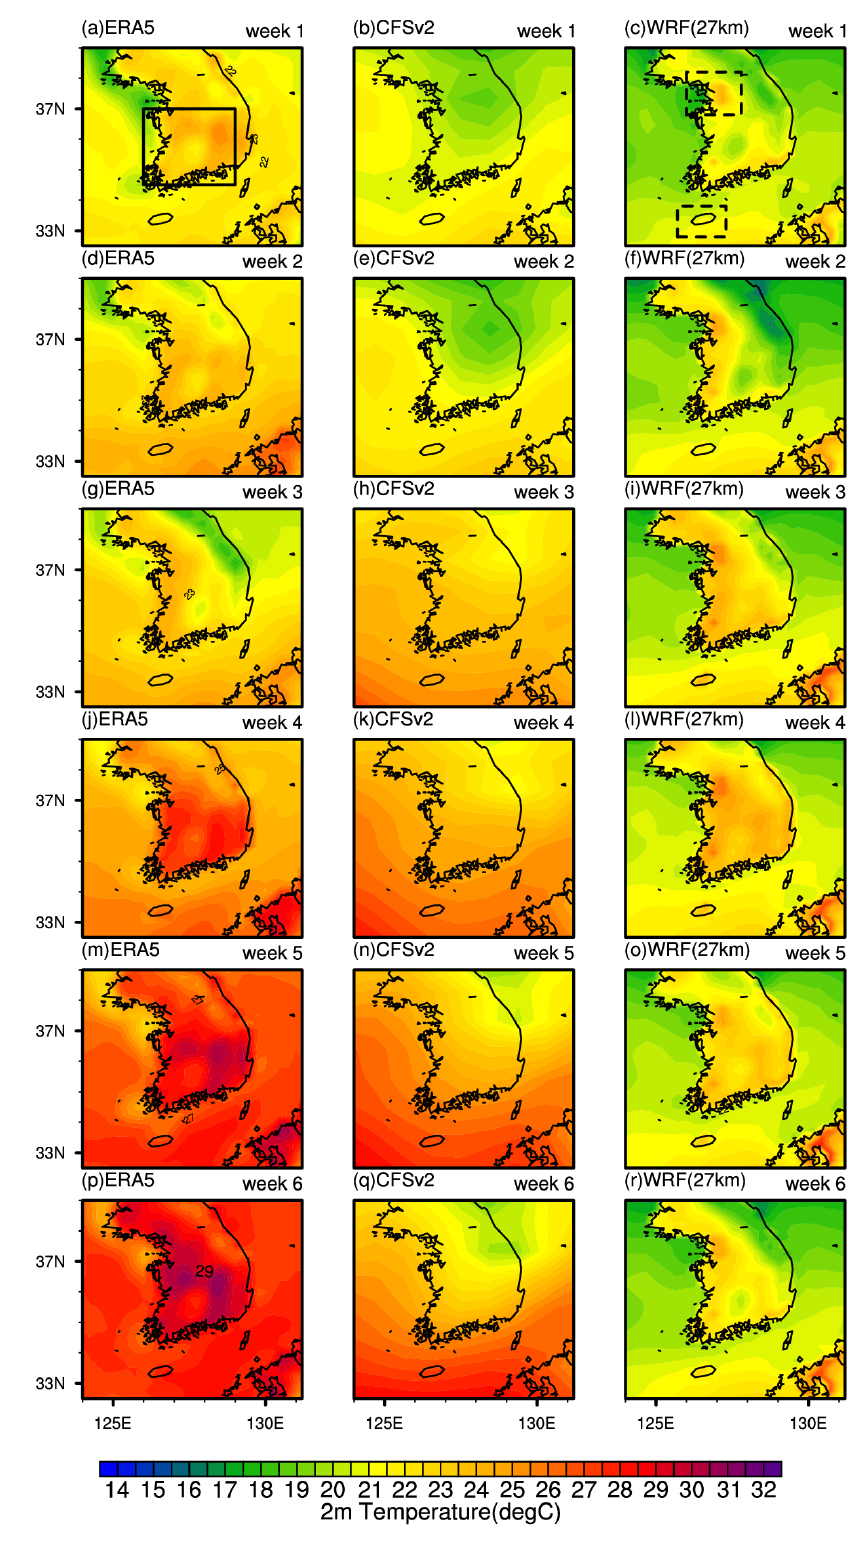
Figure 5. The weekly mean of the 2 m temperature in the ERA5 reanalysis and the CFSv2 and WRF forecasts initialized at 1800 UTC on 15 June. The solid box indicates the central and southern region in Korean Peninsula. The dotted box near 37 N represents Seoul, and the other box represents Jeju Island. From the top to the bottom of the figure (Week 1 to Week 6), the leftmost area represents the reanalysis data, the middle of the row represents CFSv2, and the rightmost area represents the WRF 27 km